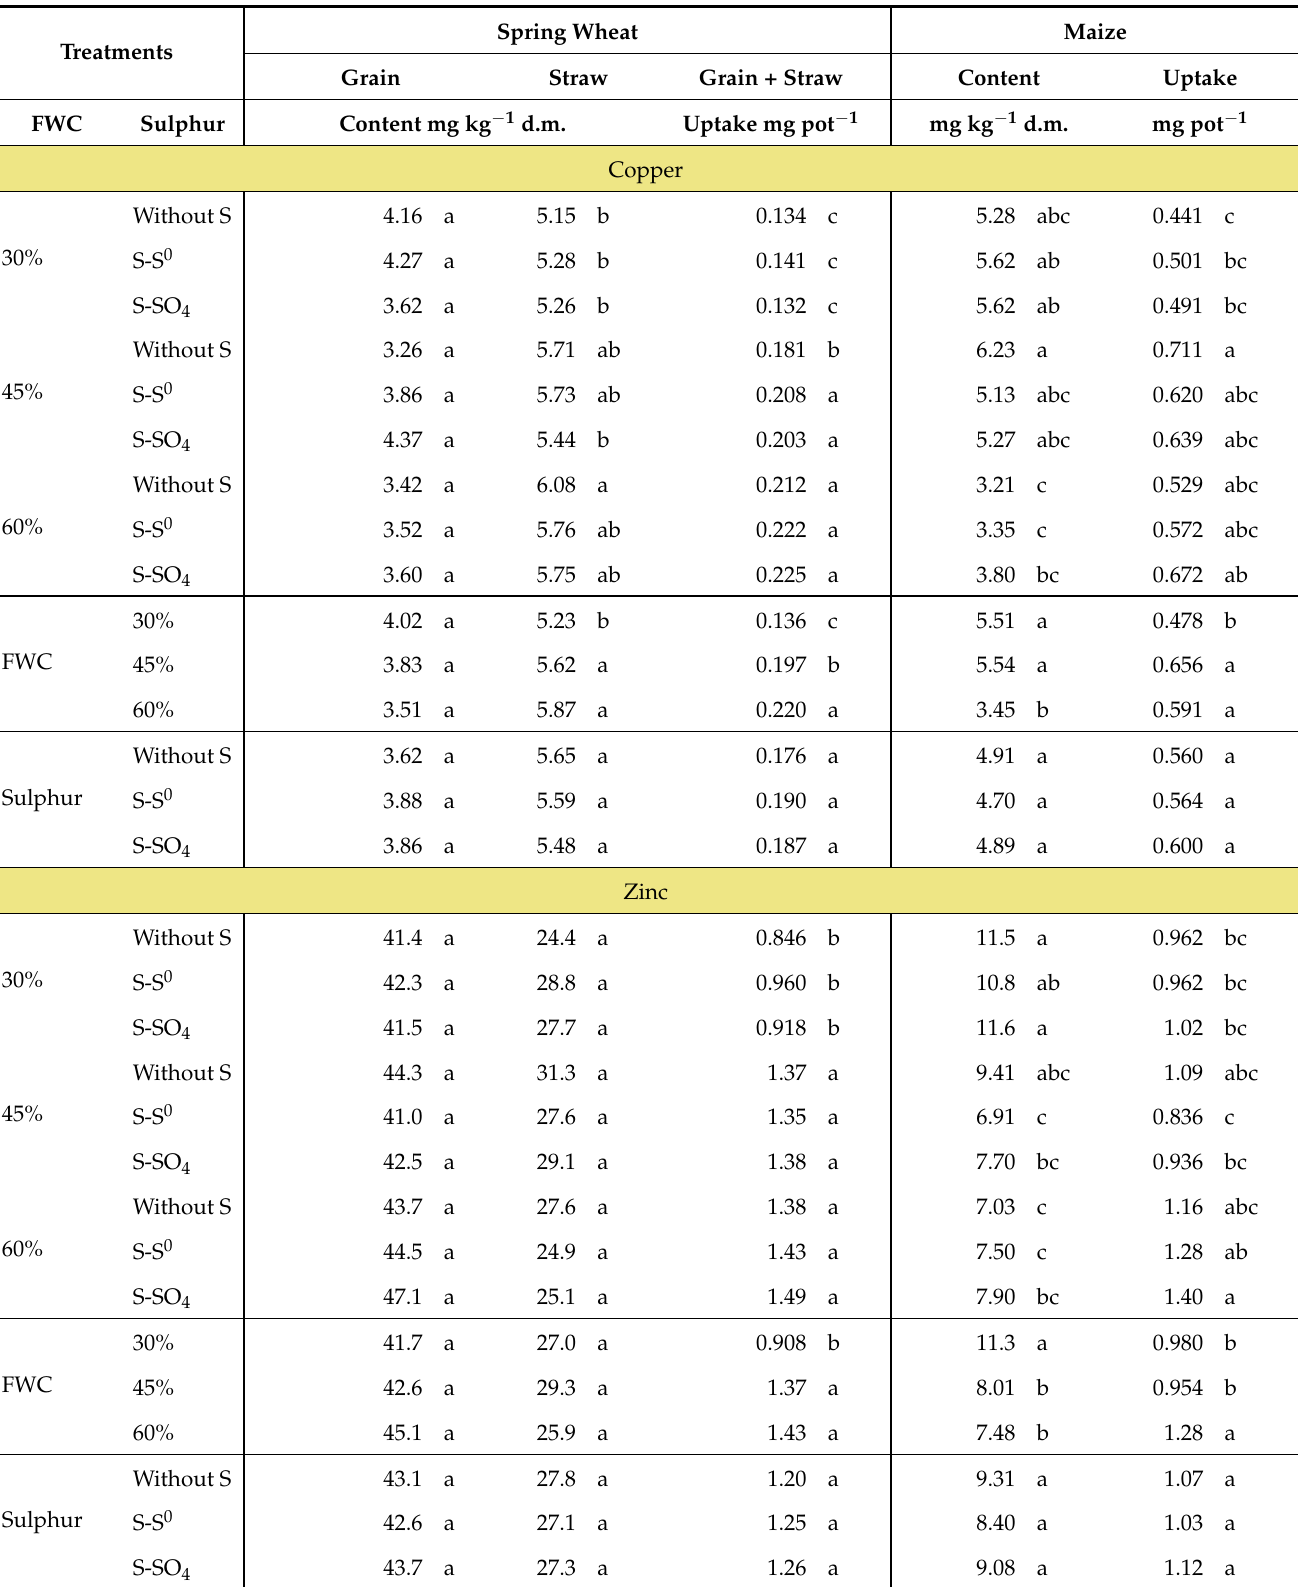
Table 7. Copper and zinc content and uptake in cultivated plants. Values indicated by the same letter are not significantly different ( α =